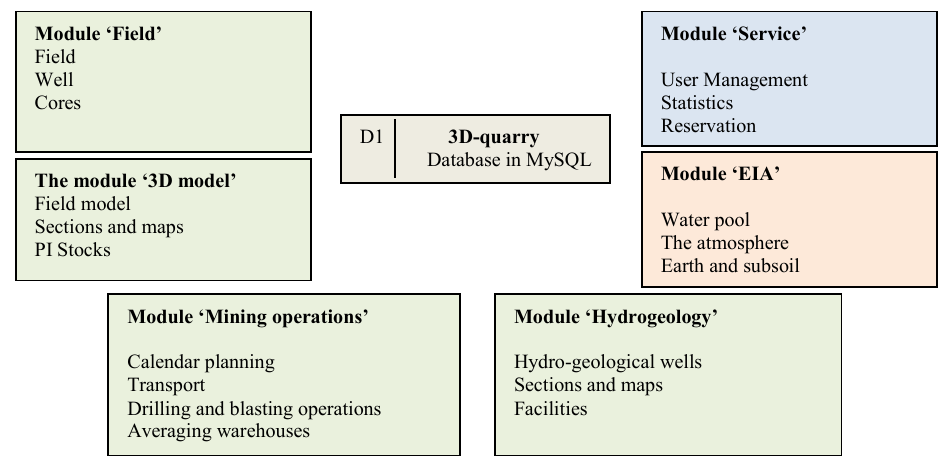
Fig. 1. Structure of the ‘3D-quarry’ system with the integration of the ‘EIA’